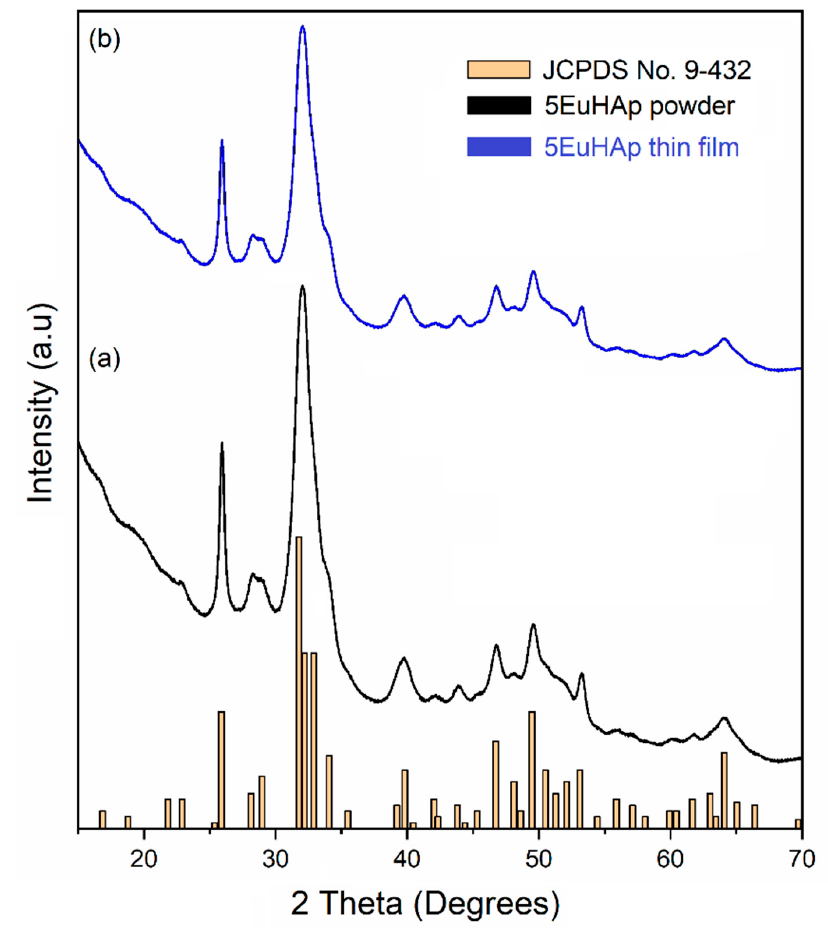
Figure 3. XRD patterns of the 5EuHAp powder ( a ) and 5EuHAp thin film ( b ). Table 1. Lattice constant and crystalline sizes calculated from the XRD patterns of the synthesized 5EuHAp suspension and thin